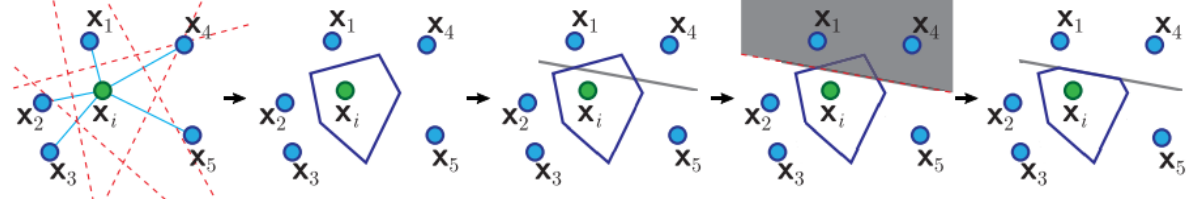
Figure 3. Generation steps for the Voronoi element under the restriction of an irregular boundary (step (a) and step (b)) [30]. X i is the point to be adjusted, and X 1 ‐ X 5 are the five points surrounding X i .